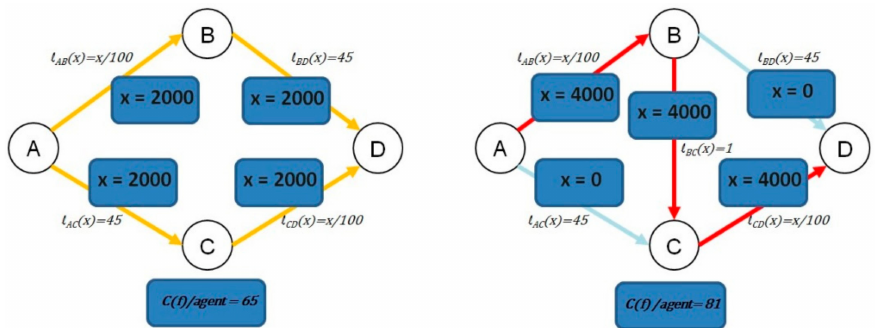
Figure 2. Nash equilibrium flow and corresponding cost per agent C ( f )/ agent = 65 in the original network ( left ), and Nash flow after insertion of a high capacity edge ( right ). After adding the high capacity edge to the network, the total cost per agent C ( f )/ agent = 81, which is higher than in the original